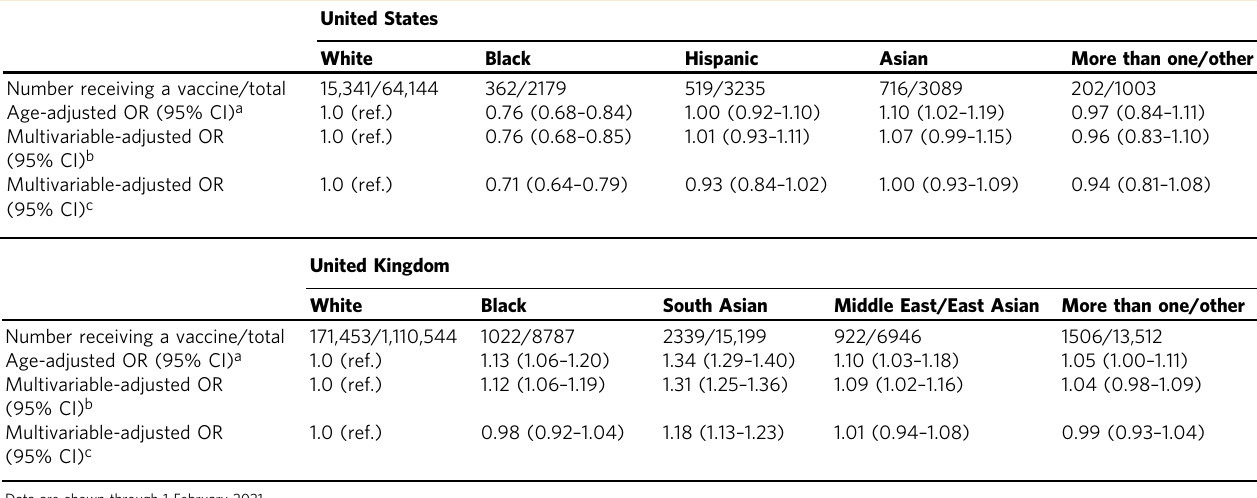
Table 2 Vaccine uptake by race and ethnicity according to country of enrollment among all participants.